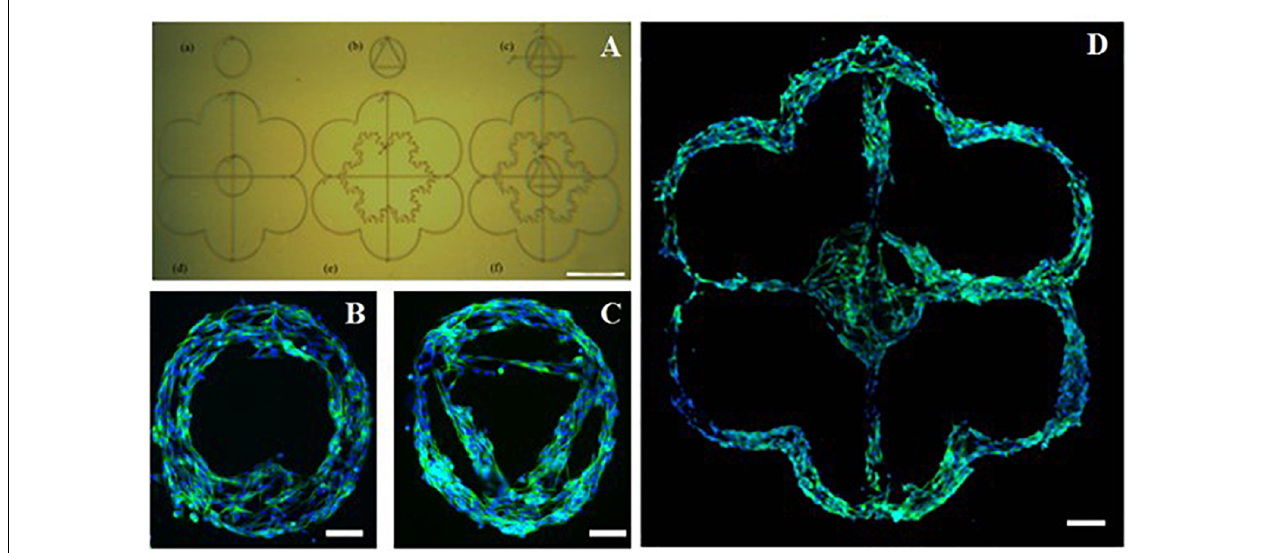
FIGURE 6 | Complex poly(3,4-ethylenedioxythiophene)-poly(styrenesulfonate) (PEDOT:PSS) pattern printed onto a poly(potassium 3-sulfopropyl methacrylate) (PKSPMA) coated glass substrate generated via AJP. (A) Patterned surface imaged before cell culture. (B–D) Morphological staining of SH-SY5Y neuroblastoma cells cultured on patterned substrate. Green = β -tubulin, blue = DAPI. (Scale bar (A) = 500 µ m, (B,C) = 50 µ m, (D) = 100 µ